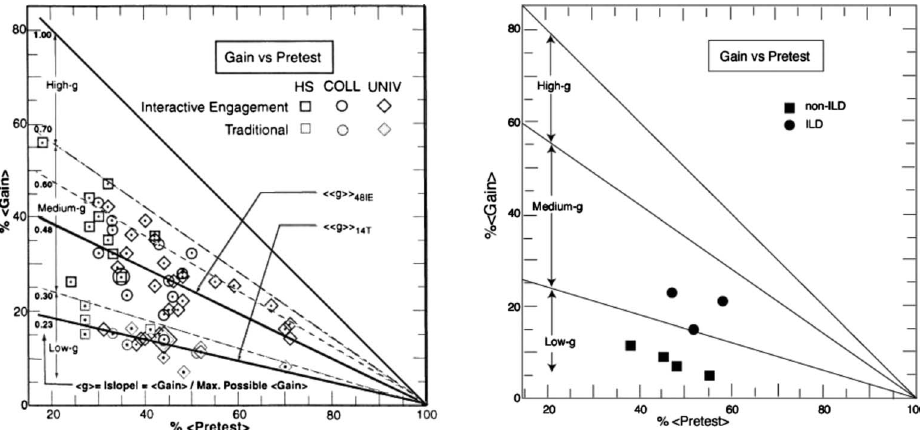
FIG. 4. Raw gains vs preinstruction score, (cid:1) a (cid:2) from Hake (cid:3) 9 (cid:4) measured by the FCI, and (cid:1) b (cid:2) for the current project, measured by